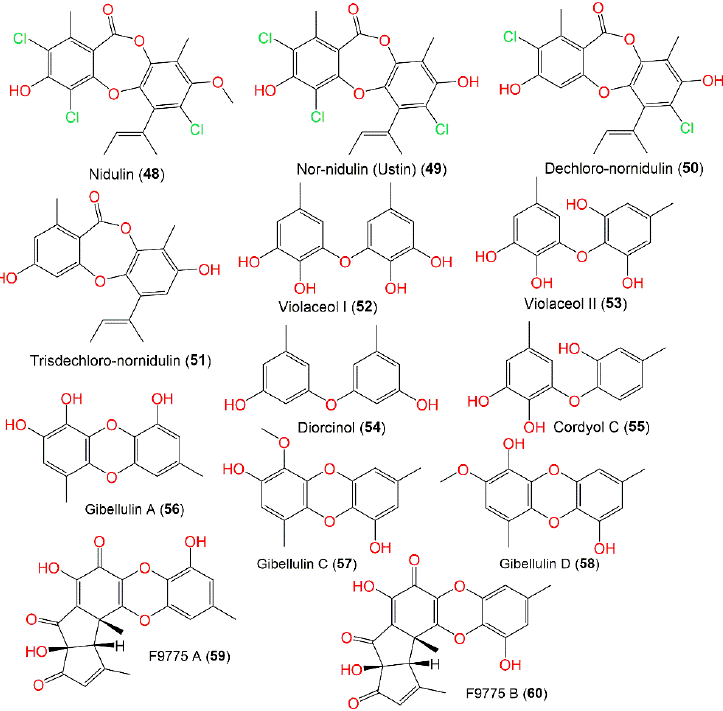
Figure 5. Structures of depsidones ( 48 – 51 ) and biphenyl ethers ( 52 – 60 ).